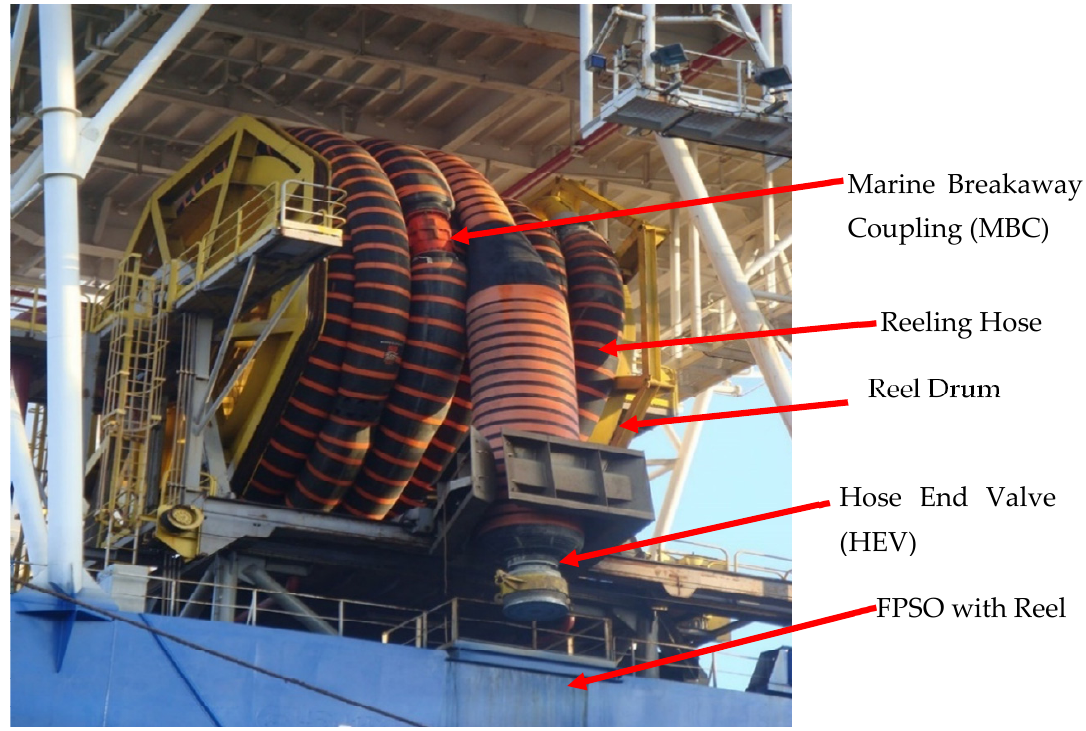
Figure 15. Offshore reeling hose stored on the reel-drum showing reel, Marine Breakaway Coupling (MBC) and Hose End Valve (HEV).